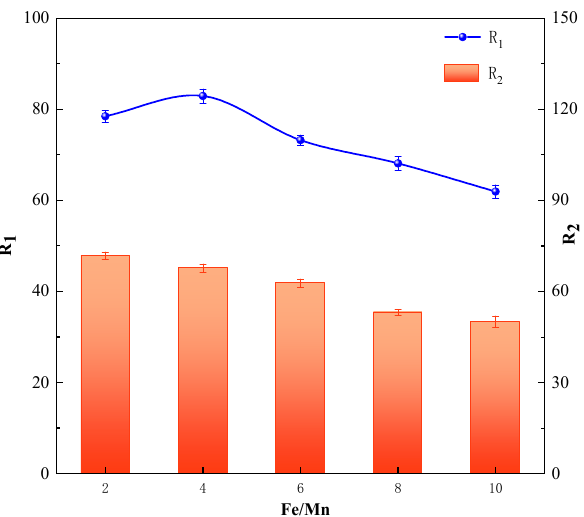
Figure 5. Effect of the initial concentration ratio of iron and manganese ions on the iron and manganese ions’ removal. R 1 is the iron ion removal rate; R 2 is the manganese ion removal rate.